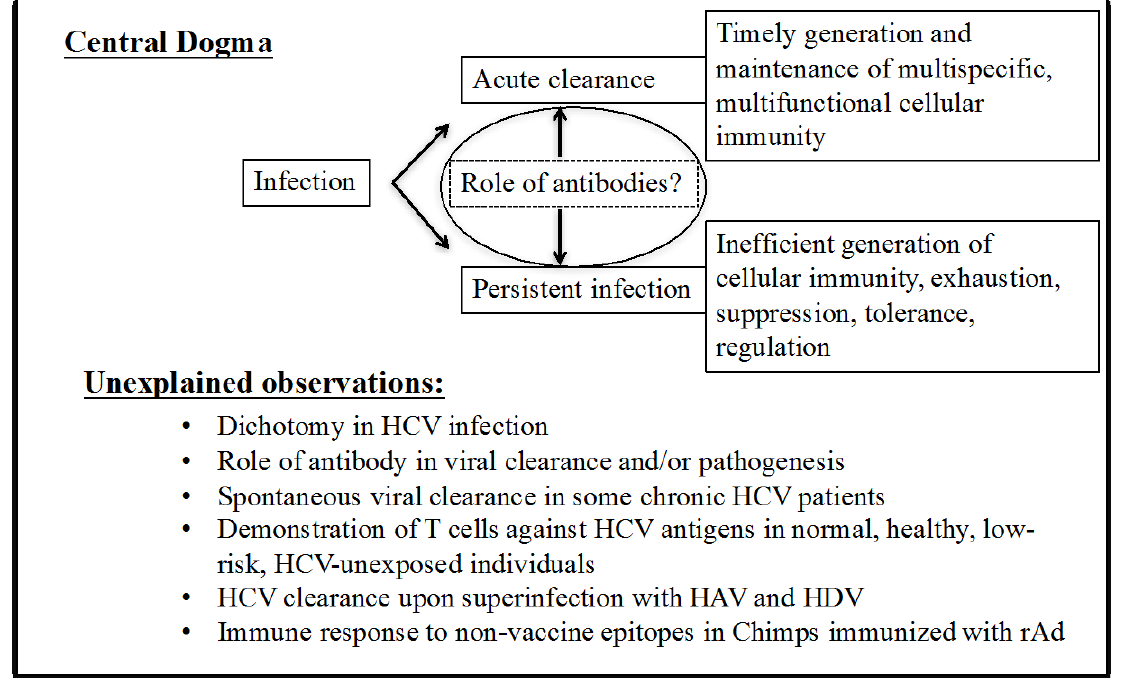
Figure 2. Enigmas of HCV immunity. Abbreviations: HCV, hepatitis C virus; HAV, hepatitis A virus; HDV, hepatitis delta virus; rAd, recombinant adenovirus.